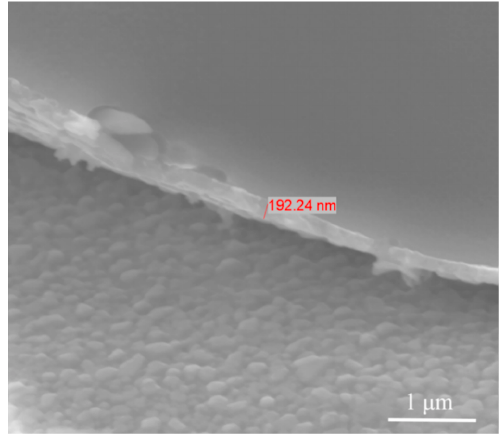
Figure 13. The morphology of cross-sectional of oxide film after being held in Al-4.5Mg alloy melt for 15 min.